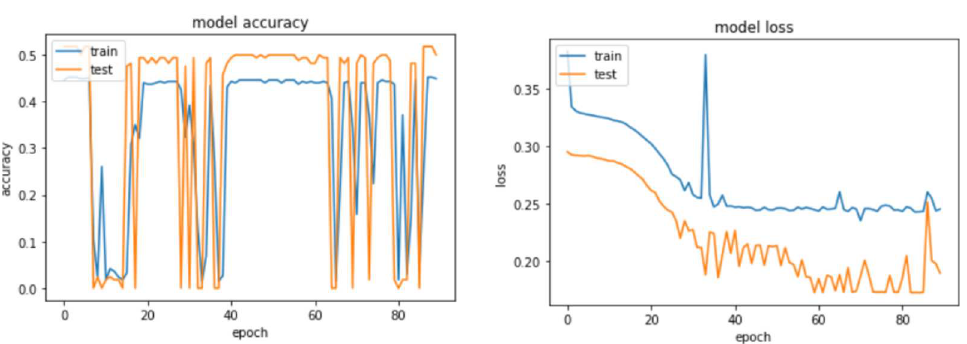
Fig 29. (a) Instability of accuracy. (b) Loss minimization.